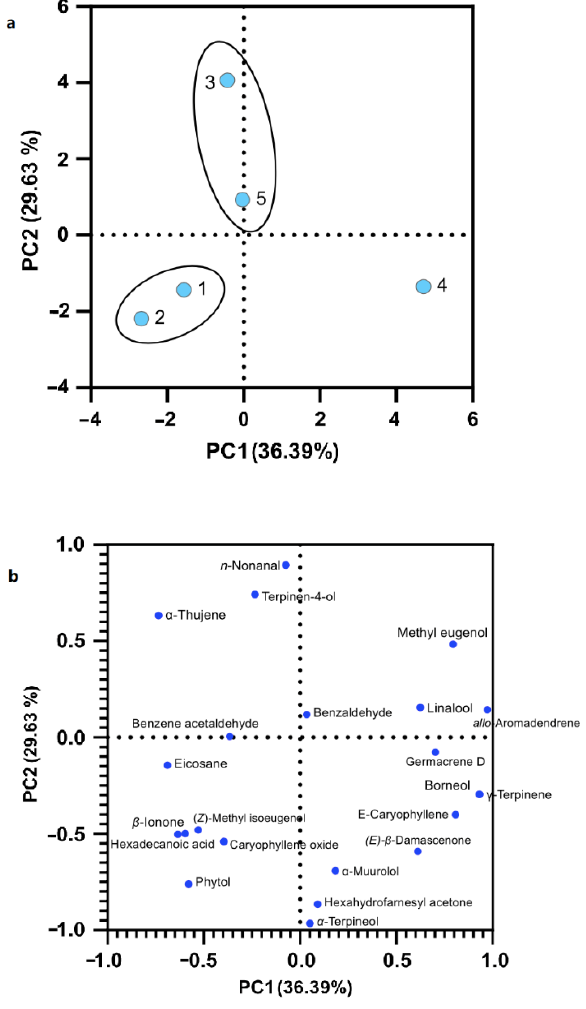
Figure 5. PCA analyses of volatile compound in the amount larger than 1% from essential oils (EOs of Barrelier’s Speedwell from five locations). ( a ) PCA score plot allocating different locations into clusters (locations numbers 1–5 stated in the Table 1); ( b ) PCA loading plots of volatiles from the first and second principal